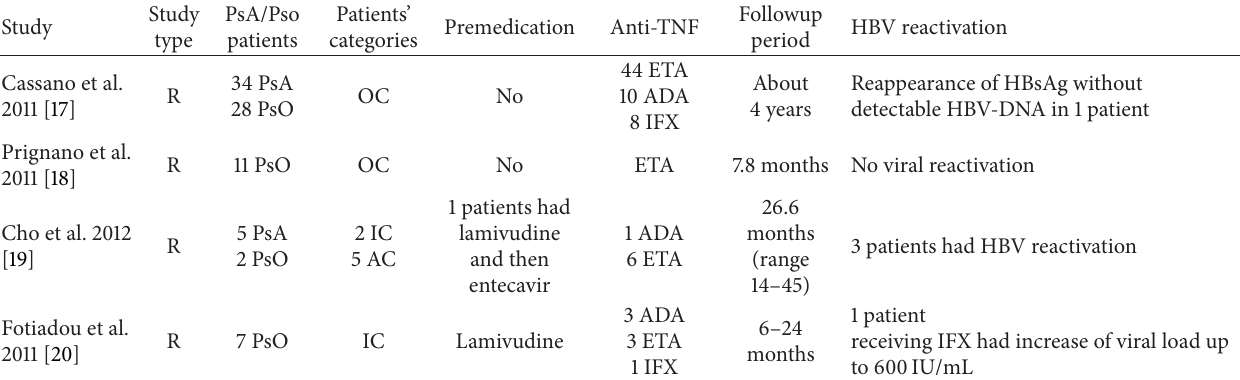
Table 3: Previous reports about anti-TNF use in HBV active/inactive/occult carriers with psoriatic